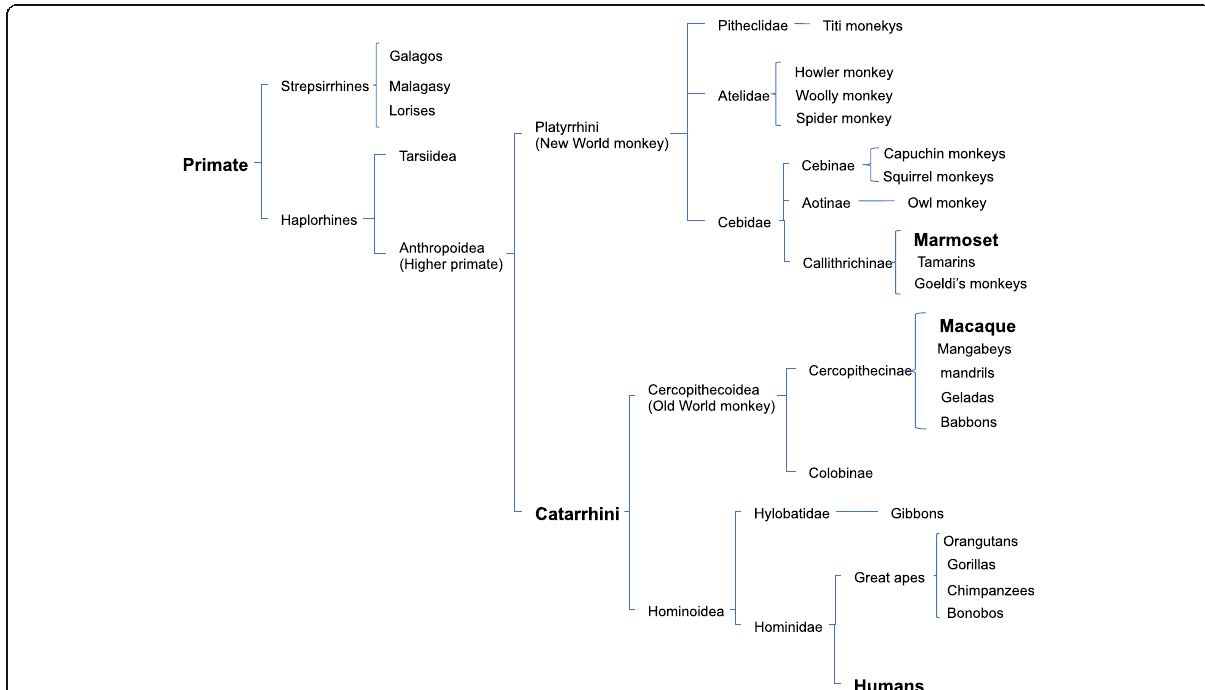
Fig. 1 Taxonomic classification of extant primates. Macaques are closer to humans in the taxonomic classification. Hominoidea cannot be used for experiments for ethical reasons. Cercopithecoidea (Old World monkeys) is available as experimental animals that are closer to humans than other primates to humans. This figure combines Fig 4.23, Fig 5.28, Fig 6.22, and Fig 7.17 in reference